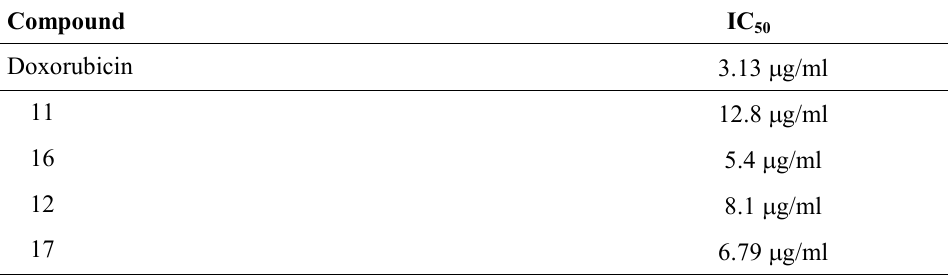
Table (3): Effect of some selected newly synthesized compounds on breast cancer cell line.